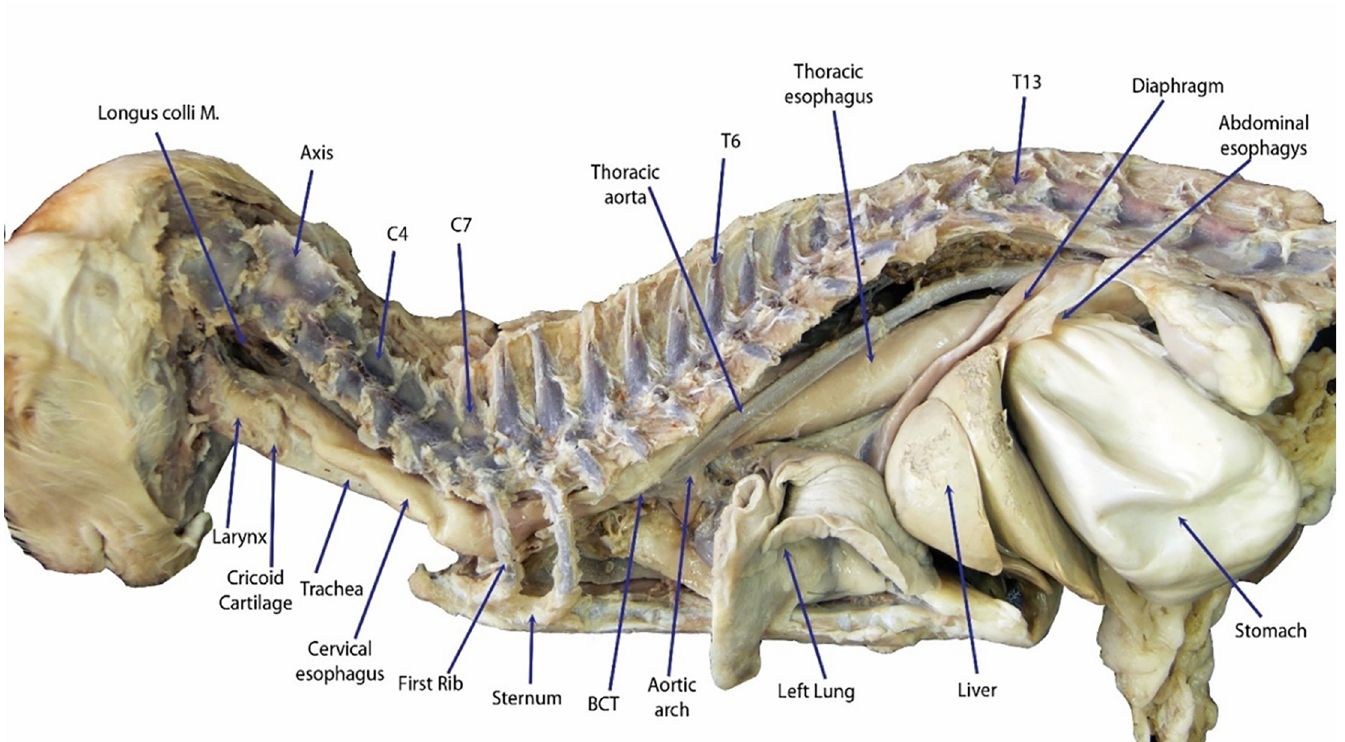
Fig 5. Dissected fixed cat, left side; the course of the entire oesophagus is shown. https://doi.org/10.1371/journal.pone.0233983.g005 trachea. At the level of the 7 th cervical vertebra (Figs 5 and 6), the thoracic oesophagus bends caudo-dorsally to enter the thoracic cavity and continues in same direction, just dorsal to the brachiocephalic artery and brachiocephalic trunk and on the left side of trachea. At the level of the 6 th thoracic vertebra, the oesophagus inclines above the tracheal bifurcation and bends to the right of the ascending aorta, just above the aortic arch. The oesophagus continues in a dorso-caudal direction, with a slight tilting towards the left side (Fig 7), below the thoracic aorta in the mediastinum to penetrate the diaphragm through the oesophageal hiatus just below the 13 th thoracic vertebra. The thoracic oesophagus has a wide lumen in the area below the thoracic aorta, as shown in Fig 8. The abdominal oesophagus (Figs 5 and 9) is short and curves downward above the dorsal border of the liver to enter the stomach.